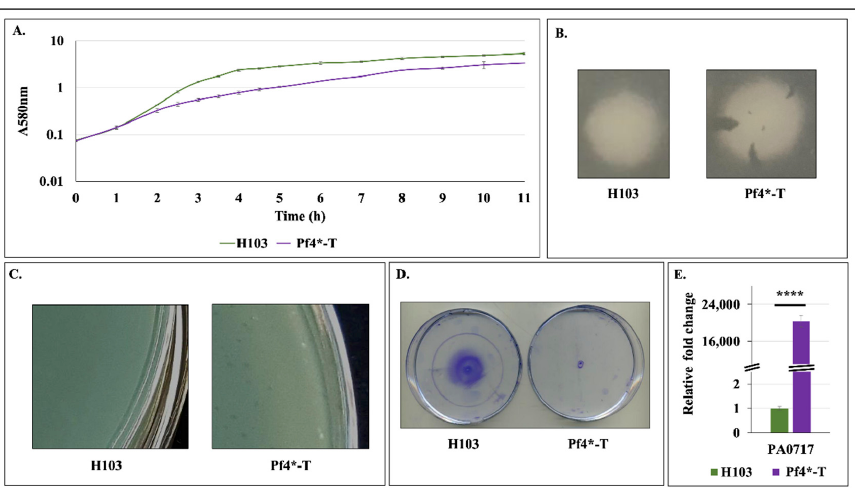
Figure 2. Effect of Pf4 phage variant on P. aeruginosa H103 strain. ( A ). Growth curves of H103 control strain and Pf4*-treated H103 (Pf4*-T) ± SEM. ( B ). Colony morphology of H103 and Pf4*-T. ( C ). Lysis